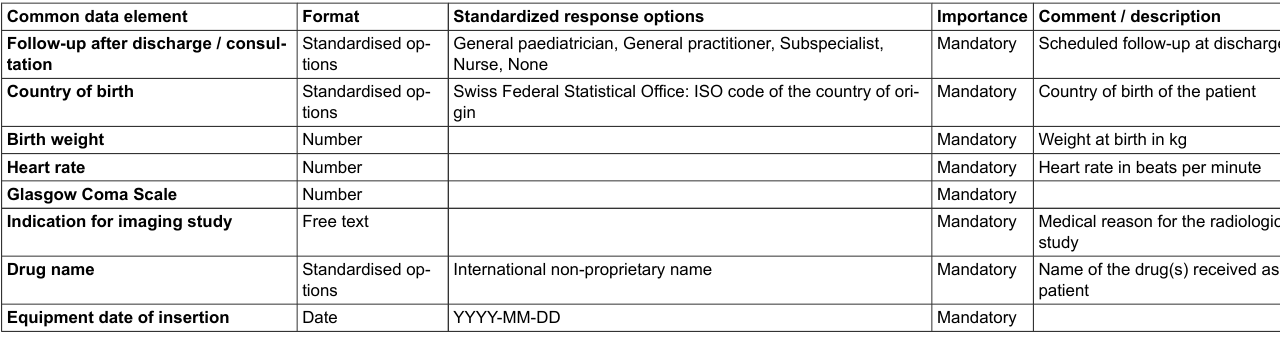
Table 2: Examples of common data elements (CDEs) of the core module (general paediatrics) of SwissPedData. Common data